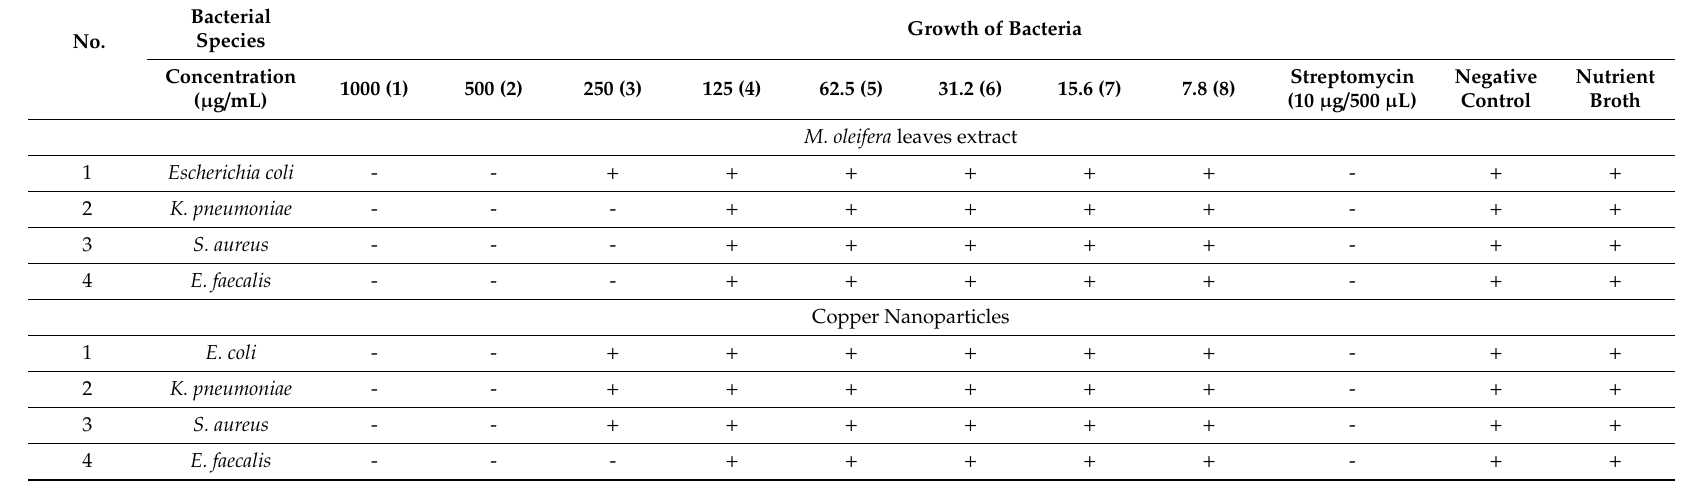
Table 6. Anti-bacterial activity data (growth ( + ) and no growth